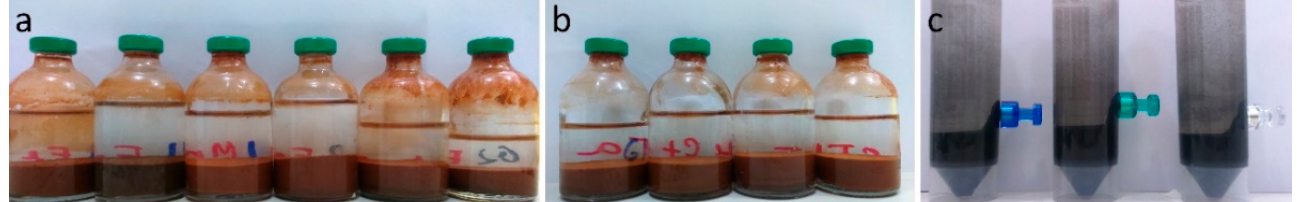
Figure 3. Evolution of the solid phase of long-term enrichment cultures containing synthetic Fe(III) oxyhydroxides as the Fe(III) source. Inocula were obtained from the Gualaxo do Norte River affected (GNR-BL) or not (GNR-M) by tailings from the Fundão Dam. ( a ) Cultures 20 days old. From left to right: GNR-M-A, GNR-M-B, GNR-M-C, GNR-BL-A, GNR-BL-B, and GNR-BL-C. Note the darker color of the second flask (GNR-M-B). ( b ) Control (autoclaved) cultures 20 days old, where the solid phase shows a uniform rust color. ( c ) Solid phase retrieved after 170 days of incubation, showing magnetic minerals attracted to small, strong magnets. The magnetic interaction energy is sufficient to maintain the magnets suspended on the flask walls. From left to right, the samples are GNR-M-B, GNR-M-C, and GNR-BL-A.